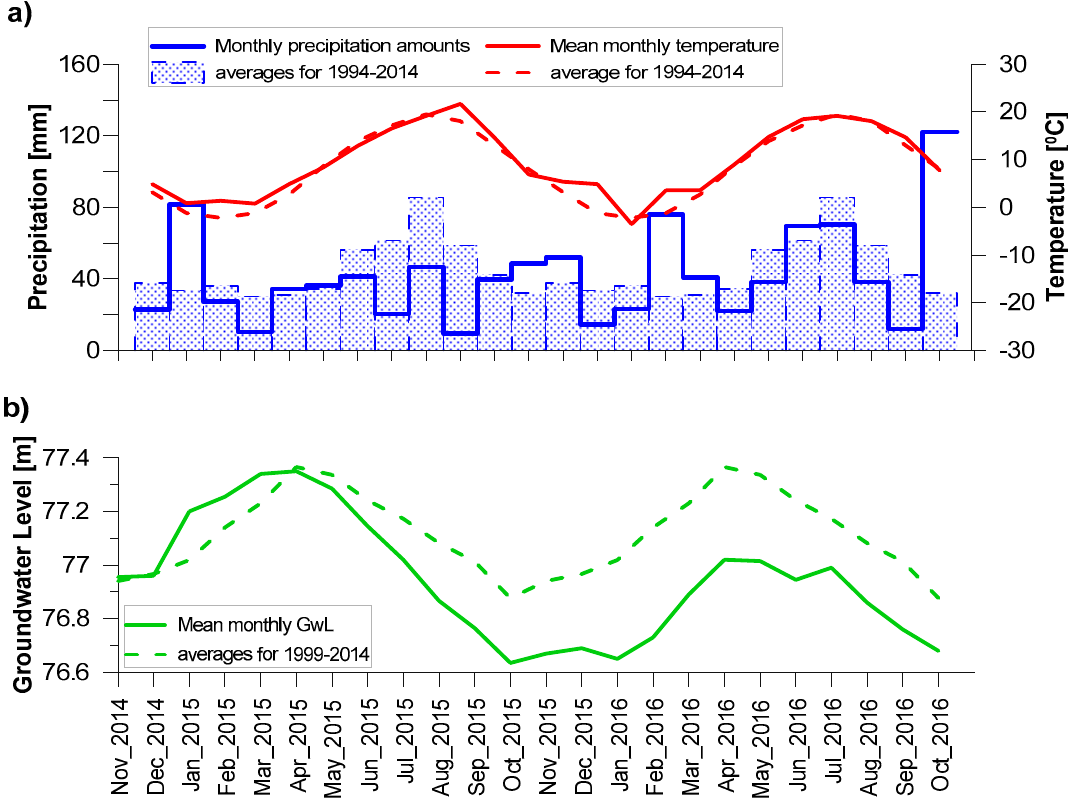
Figure 1. Monthly precipitation amounts, monthly mean temperature ( a ) and ground water level ( b ) during the study period along with averages from the years 1994 to 2014—precipitation and temperature, and 1999 to 2016—ground water level, respectively.